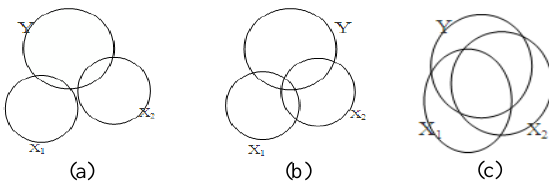
Figure 2. Correlation type of independent variables (a) not collinear, (b) weak collinear, and (c) perfect collinear